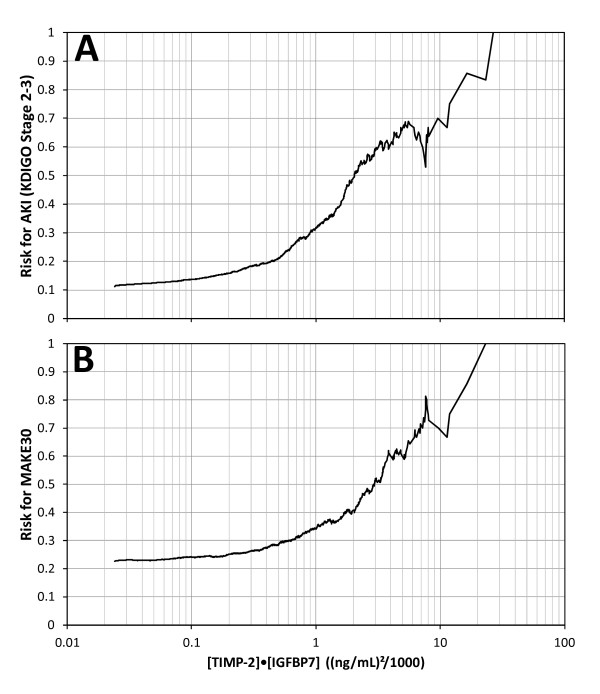
Risk for KDIGO stage 2 to 3 AKI (A) and MAKE30 (B) as a function of urine [TIMP-2]·[IGFBP7]. Risk at each [TIMP-2]·[IGFBP7] value along the abscissa was calculated as follows: the number of samples positive for the endpoint that had [TIMP-2]·[IGFBP7] above the abscissa value divided by the total number of samples that had [TIMP-2]·[IGFBP7] above the abscissa value. Slightly more than 50% of the samples had a [TIMP-2]·[IGFBP7] value above 0.3 where risk began to elevate sharply and about 10% of the samples had a [TIMP-2]·[IGFBP7] value above 2.0 where risk almost doubled and quintupled for MAKE30 and AKI, respectively. AKI, acute kidney injury; IGFBP7, insulin-like growth factor-binding protein 7; TIMP-2, tissue inhibitor of metalloproteinases-2.